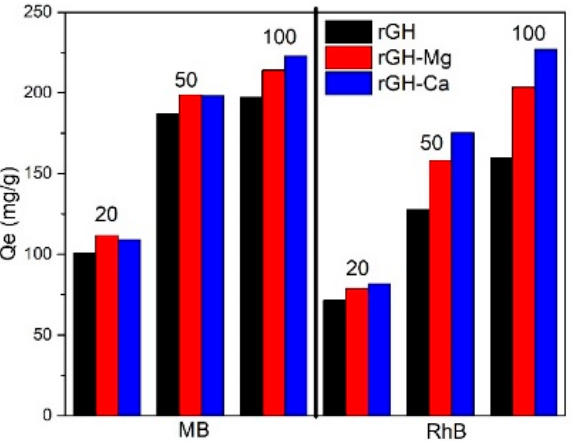
Figure 5. The adsorption capacity of the rGHs using various initial concentration (20, 50 and 100 mg/L) of methylene blue (MB) and rhodamine B (RhB).